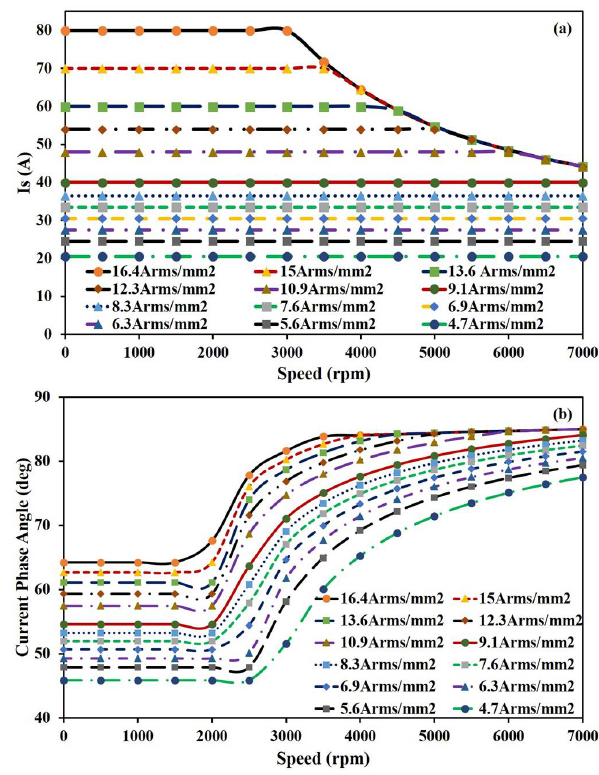
Figure 11. ( a ) Current and ( b ) current angle variations of PMa-SynRM with speed.